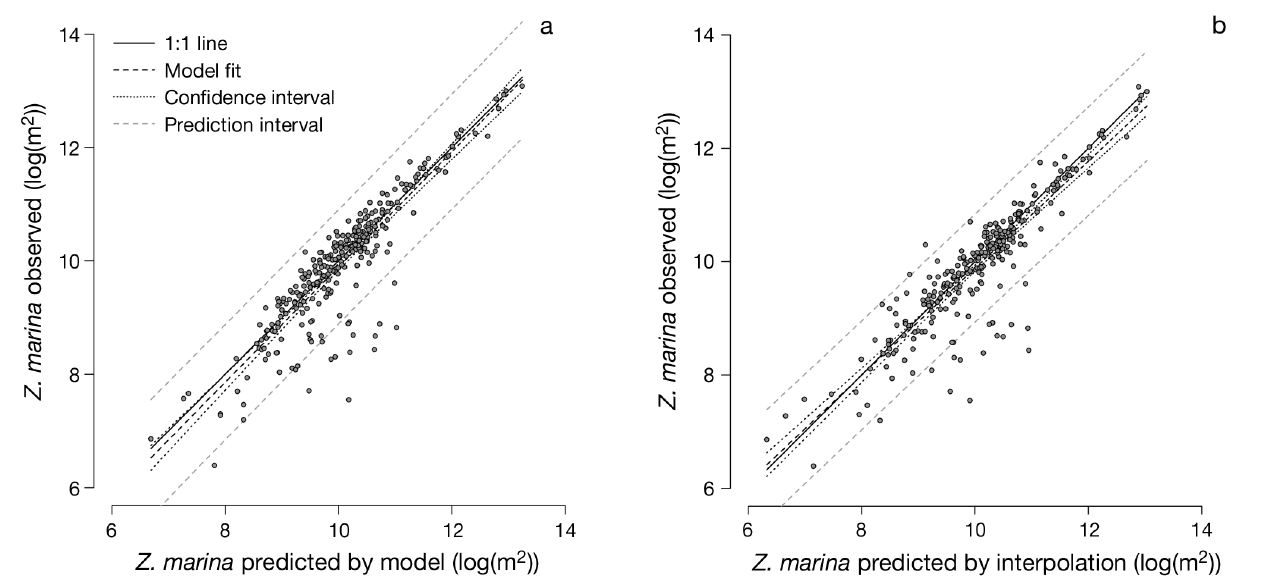
Fig. 3. (a) Relationship between predicted and observed eelgrass Zostera marina cover in all aquaculture beds for 2005 and (b) relationship between interpolated and observed Z. marina in all aquaculture beds for 2005. Model fit lines and confidence intervals overlap the 1:1 line, which indicates they had the same amount of Z. marina cover present as predicted; however, a group of beds fell well below and outside the 95% confidence and prediction